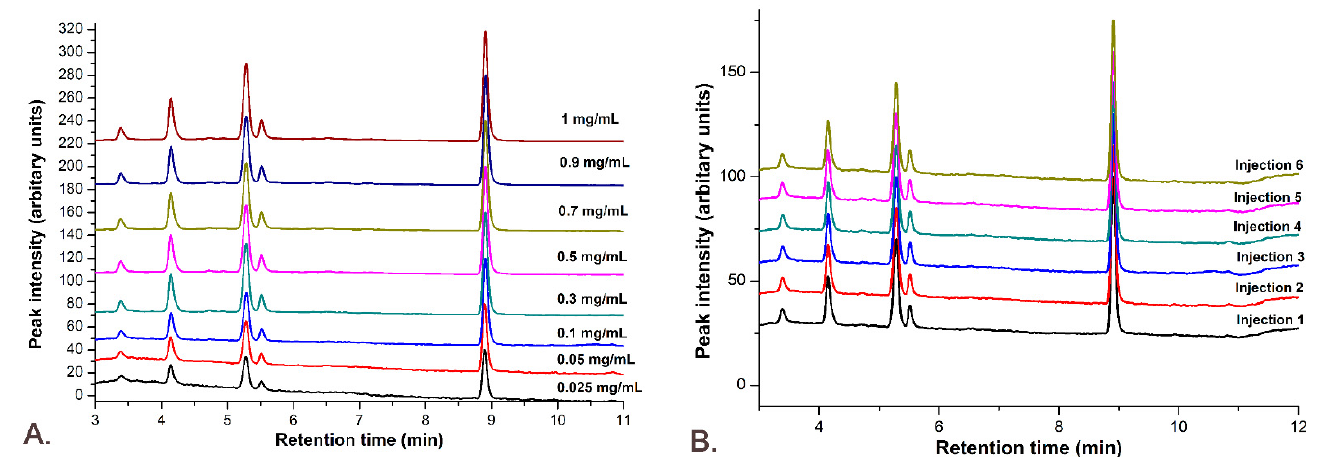
Figure 11. The M 8 method linearity: ( A ) the chromatograms for all concentrations used in the calibration curve; ( B ) all 6 injections for the concentration of 0.1 mg/mL Gli-Sil.